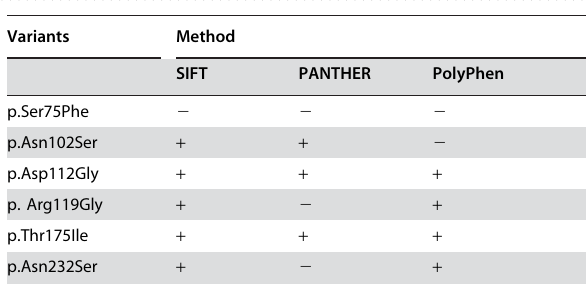
Sequence homology for SIFT prediction was calculated with the alignment of orthologs selected from Eukaryota. ‘ 2 ’ and ‘ + ’ indicate the predicted benign and deleterious effects of the mutations, respectively. doi:10.1371/journal.pone.0000685.t001 .